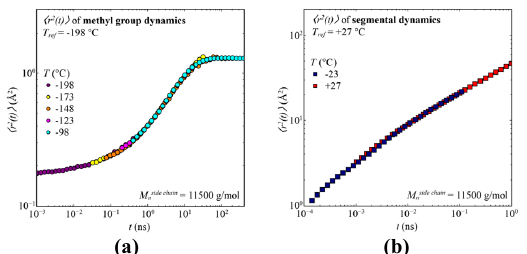
Fig. 13. Mean square displacement, ⟨𝑟 (cid:2870) (cid:4666)𝑡(cid:4667)⟩ , as a function of time, 𝑡 , for Sample 3. (a) pure methyl group dynamics. (b) pure segmental dynamics. Data has been previously published at Bichler et al .[22]